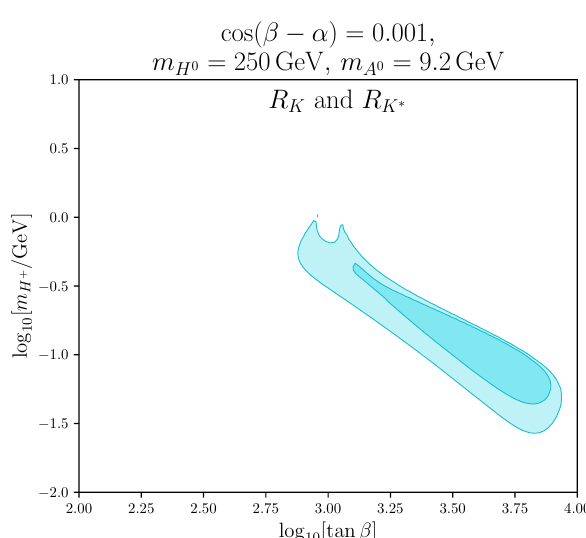
Figure 13. Contour plot of the allowed 2HDM-II parameter space in the (tan β − m for the R observables and fixing the additional parameters at their best fit point in table 2. K ( ∗ ) The lighter contour indicates the allowed parameter space at 2 σ confidence level while the darker contour corresponds to 1 σ